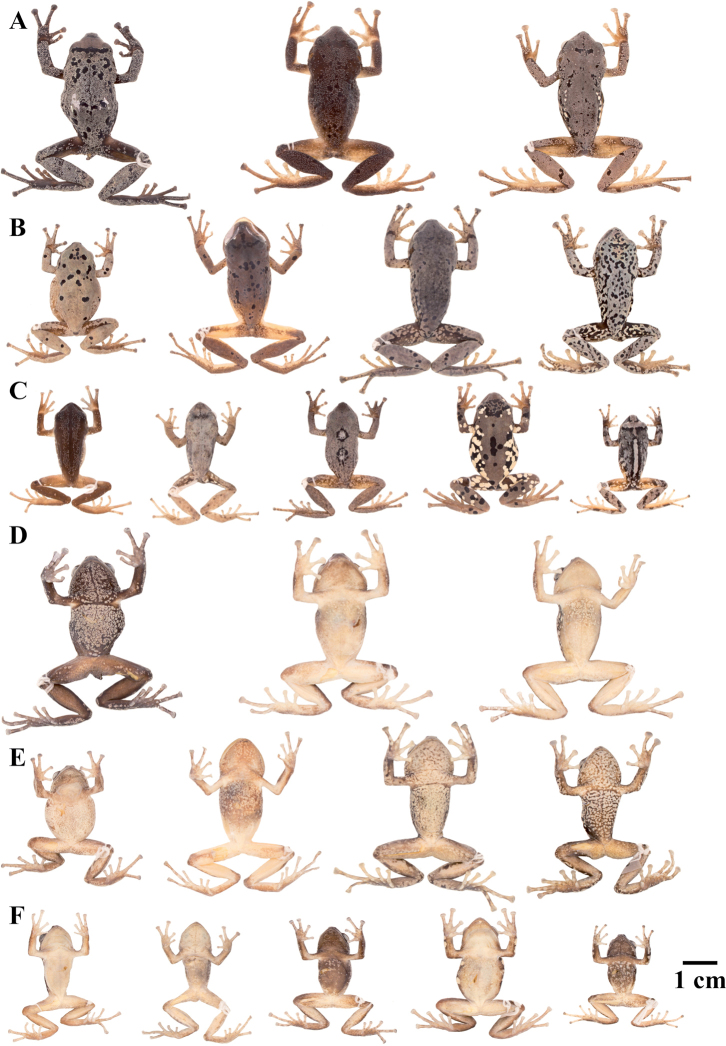
Color variation in preserved individuals of Pristimantis
multicolor sp. nov. A Dorsal view of (from left to right): QCAZ 61304 (female), QCAZ 61361 (female), QCAZ 61383 (female) B Dorsal view of: QCAZ 61394 (male), QCAZ 47214 (female), QCAZ 61310 (female), QCAZ 61283 (female) C Dorsal view of: QCAZ 61413 (male), QCAZ 61297 (male), QCAZ 61369 (male), QCAZ 61381 (male), QCAZ 61373 (male) D Ventral view of specimens in (A) E Ventral view of specimens in (B) F Ventral view of specimens in (C). See Suppl. material 2 for locality data. All specimens are shown at the same scale.